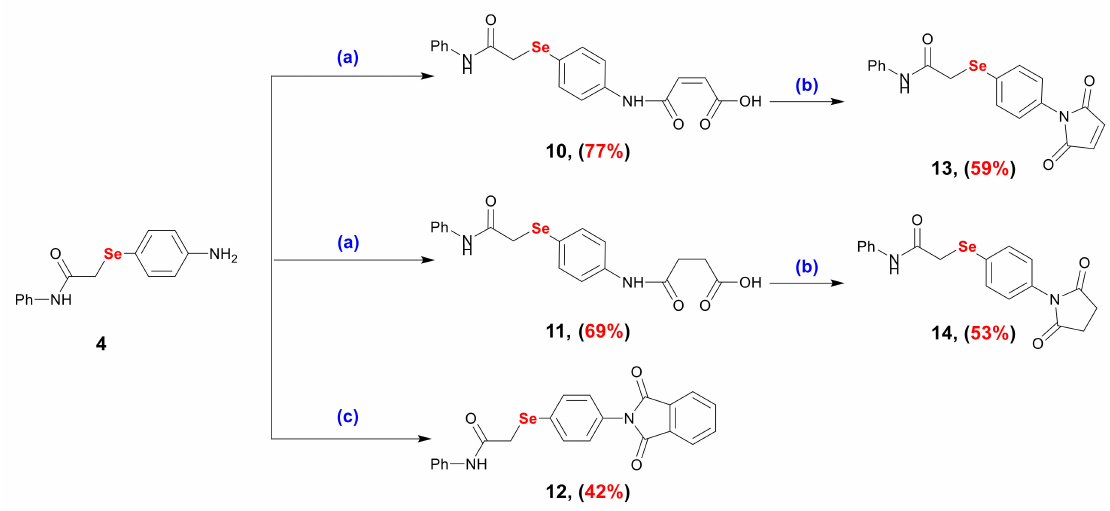
Scheme 3. Reactions of selenoamines 4 with anhydrides and subsequent dehydration. Reagents and conditions: ( a ) amine 4 (1 mmol), toluene (5 mL), maleic/succinic anhydride (1 mmol), r.t, 3